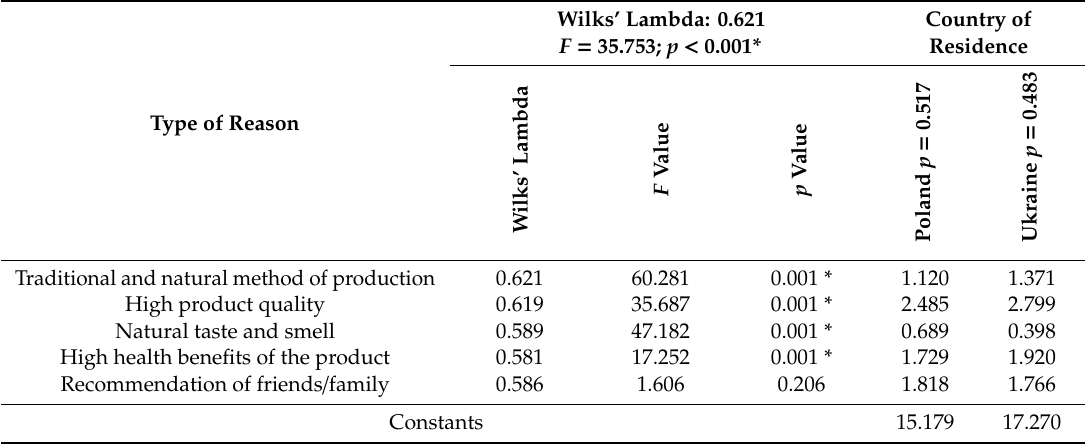
Table 3. Reasons for buying regional food